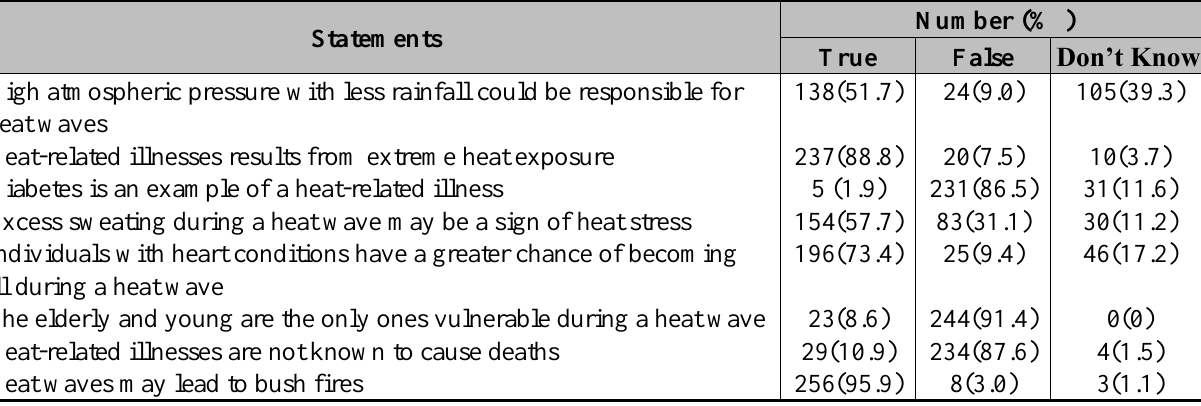
Table 3. Participants’ responses to the statements regarding knowledge about heat waves.